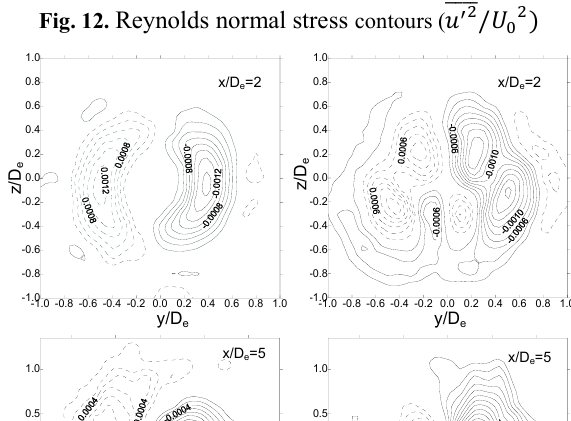
Fig. 12. Reynolds normal stress contours (